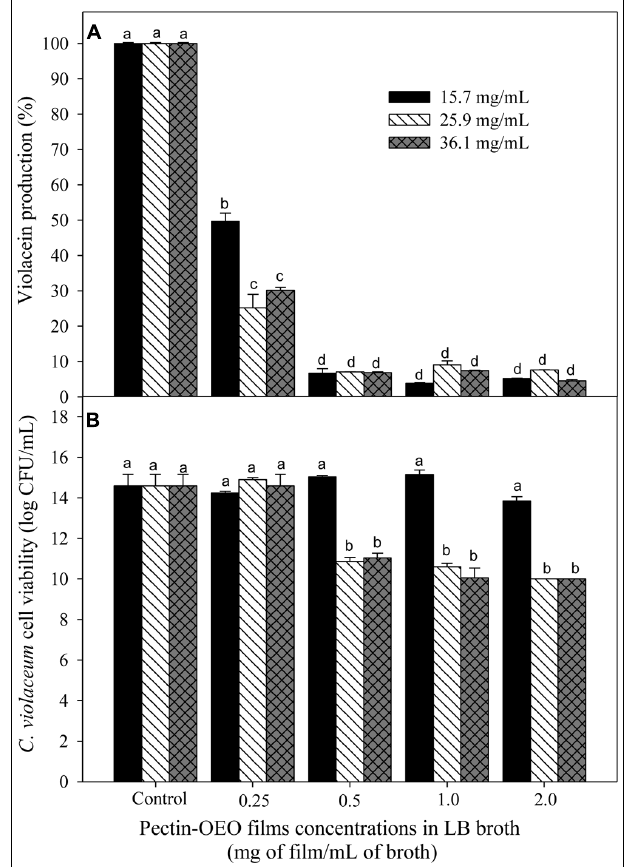
FIGURE 1 | (A) Inhibition of violacein production of C. violaceum exposed to OEO at different concentrations. (B) C. violaceum viability after incubation in LB broth enriched with different concentrations of OEO. *Significantly different when compared to control ( p < 0.05). presented antimicrobial activity against E. coli O157:H7 (Du et al.,